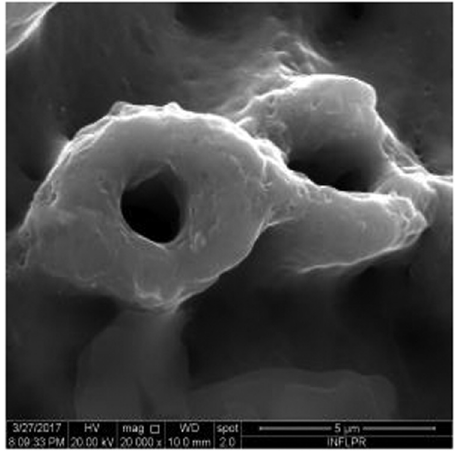
Figure 2: SEM image of sample S2 at a magni fi cation of 20k × .